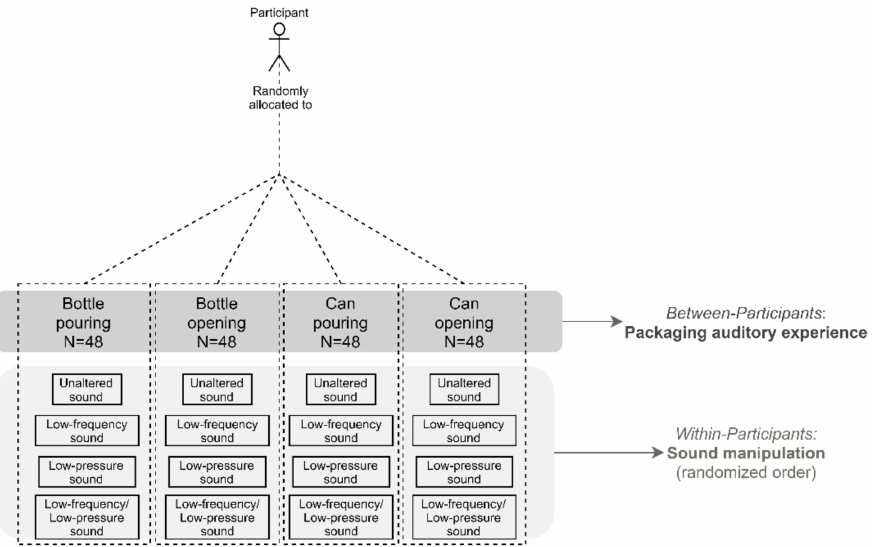
Figure 1. Design of Experiment 1, including the between- (packaging auditory experience) and within (sound manipulation)-participants